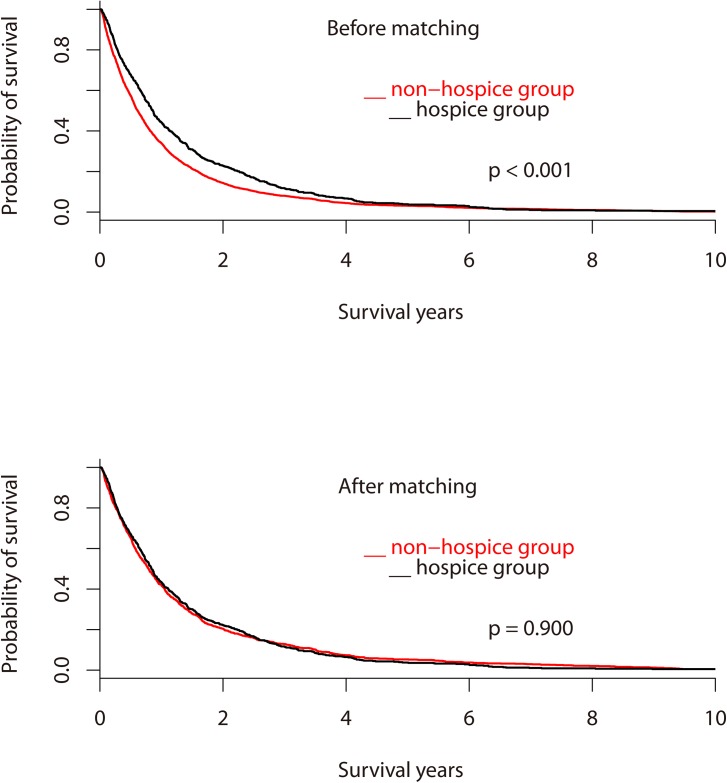
Kaplan-Meier estimates of survival curves for patients with advanced lung cancer stratified into the non-H and H groups.